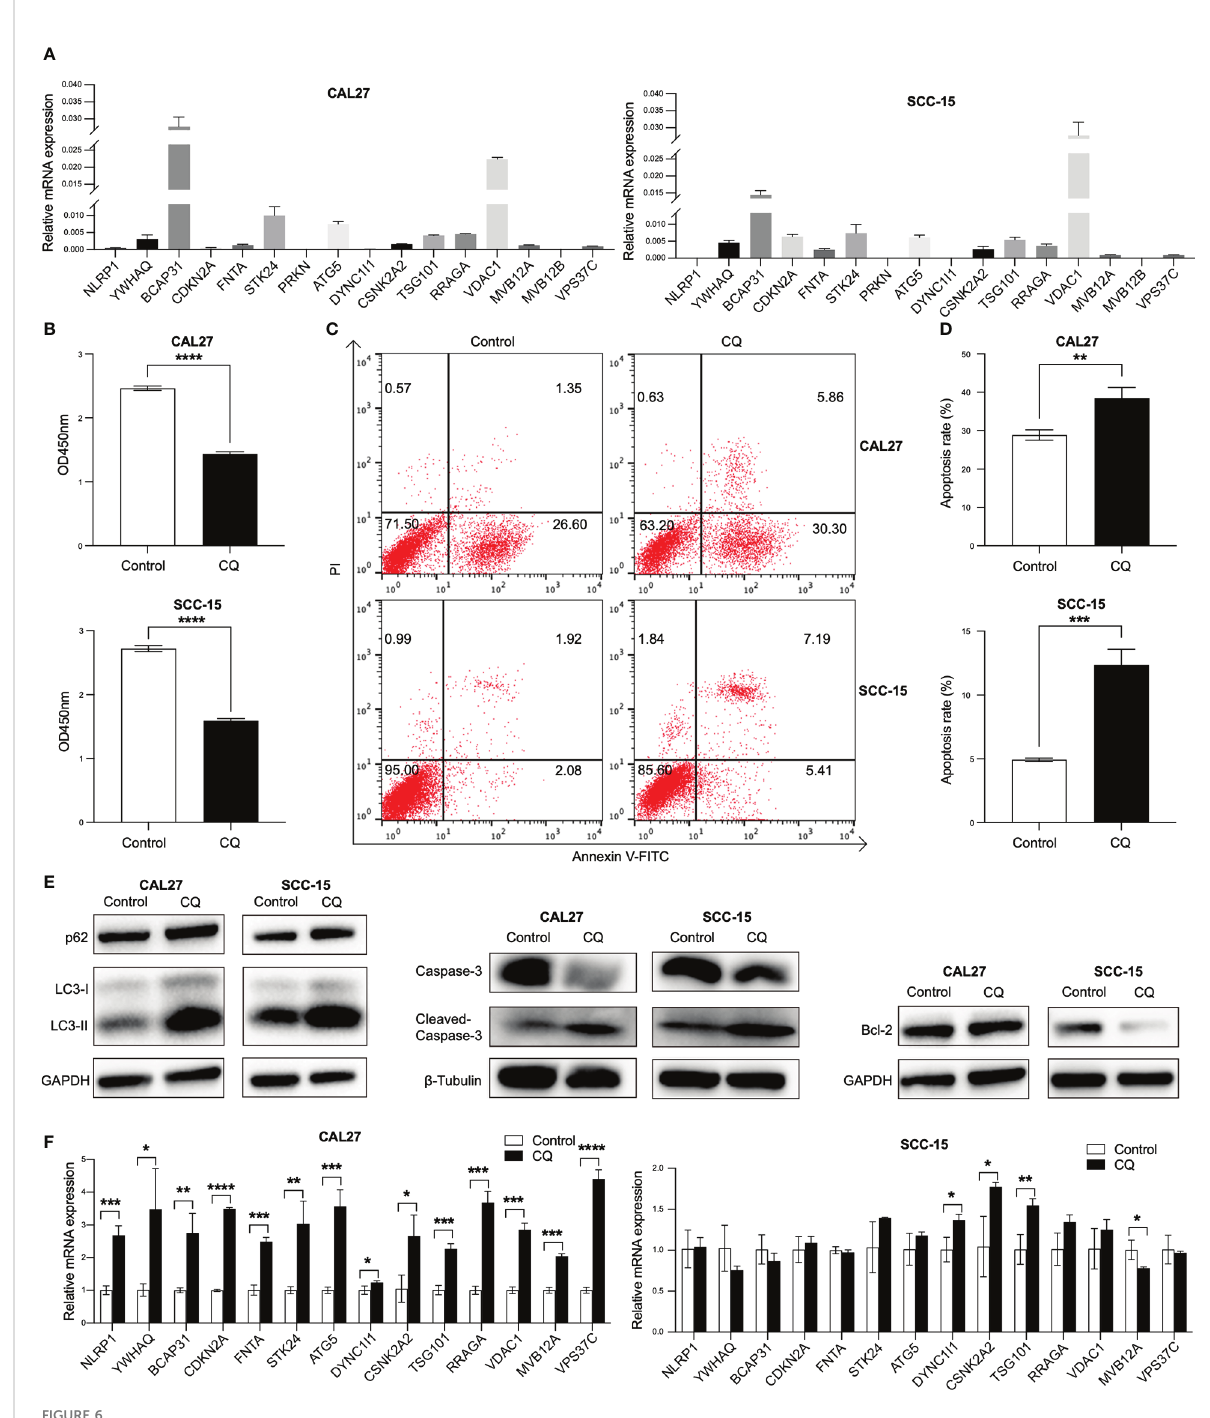
FIGURE 6 Validation of the expression of 16 overall survival associated genes in two HPV negative HNSCC cell lines. (A) The transcripts of the 16 overall survival associated genes in CAL27 and SCC-15 cell lines detected by qRT-PCR. (B) Cell proliferation after chloroquine treatment for 24 h in CAL27 and SCC-15 cell lines assessed by CCK8 assay. (C, D) Cell apoptosis post chloroquine treatment for 24 h in CAL27 and SCC-15 cell lines indicated by annexin V and PI using fl ow cytometry. (E) The inductions of autophagy-related proteins (LC3 and p62) and apoptosis-related proteins (bcl-2 and caspase-3). (F) The transcripts of 14 overall survival associated genes post chloroquine treatment in CAL27 and SCC-15 cell lines. HNSCC: head and neck squamous cell carcinoma; HPV: human papillomavirus; CQ: chloroquine. Each bar represents the mean ± SD. Statistical signi fi cance is assessed by Student ’ s t test. * P < 0.05, ** P < 0.01, *** P < 0.001, **** P <